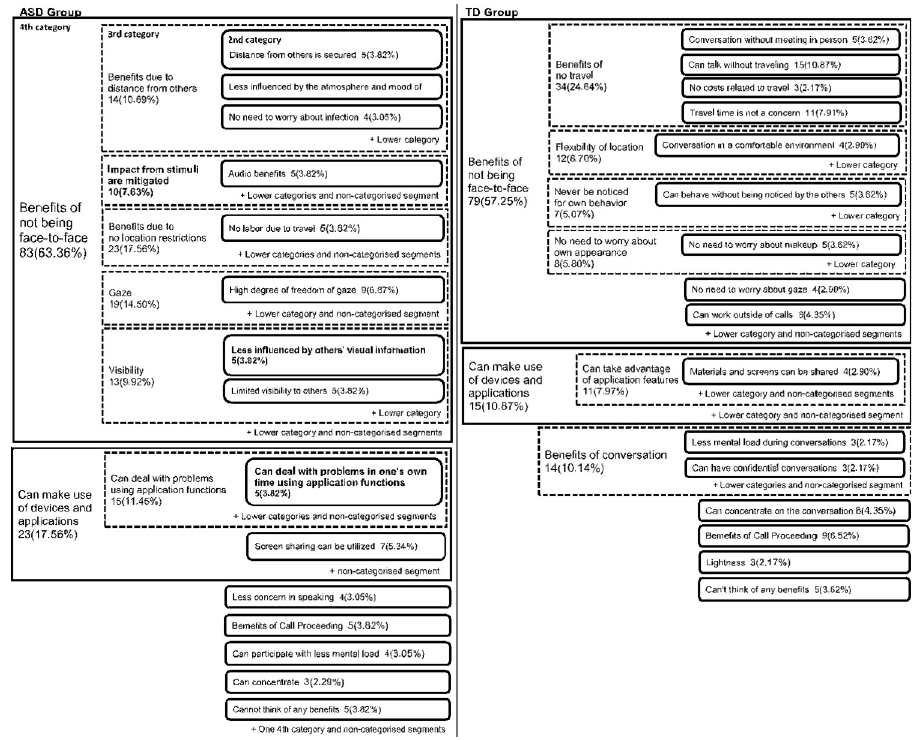
Fig 3. Results of KJ method analysis on the benefits of video calling. Bolded category names indicate categories shown to be characteristic of the ASD Group based on a comparison of the two groups. The numbers indicate the number of segments that mentioned the content belonging to the category, and the numbers in parentheses indicate the percentage of the number of all segments in each group.